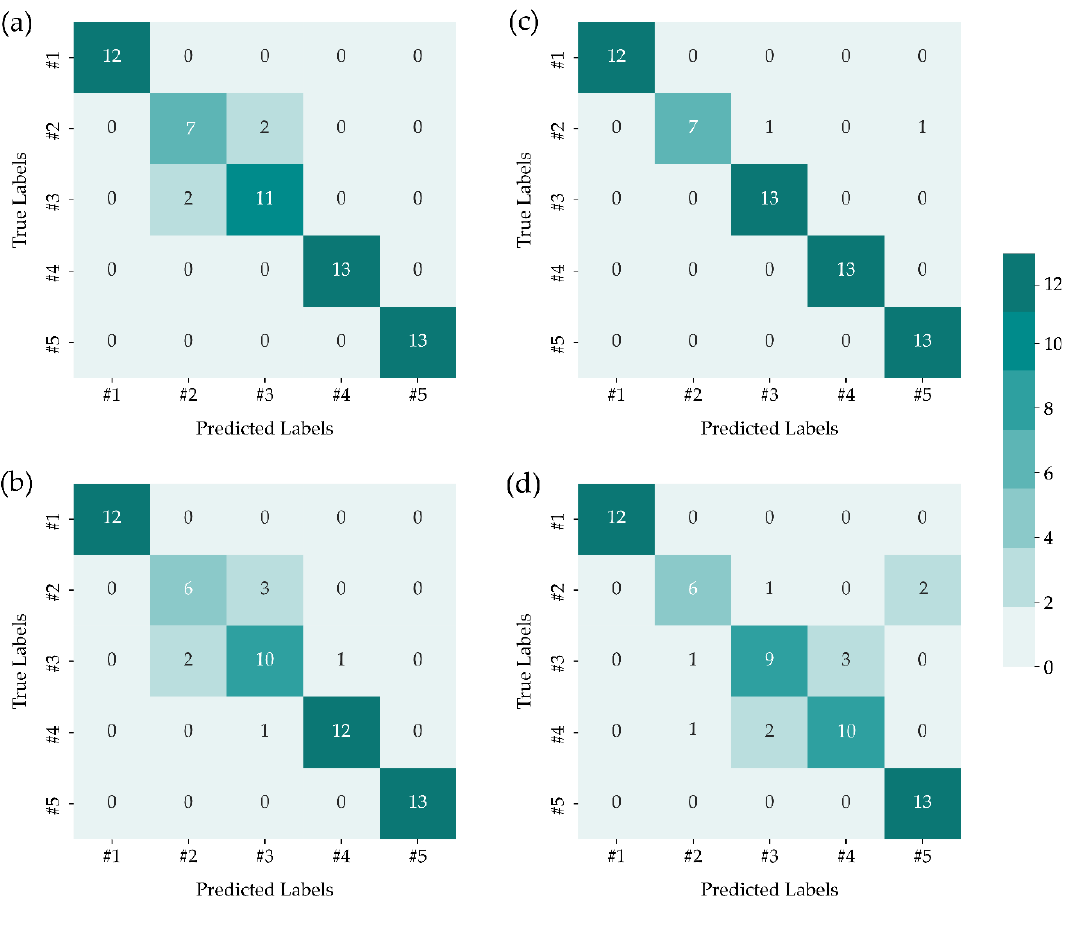
Figure 5. Confusion matrices of SVM prediction outcomes using various manifold dimensionality reduction techniques of ( a ) LTSA, ( b ) LLE, ( c ) Isomap, and ( d ) LE.